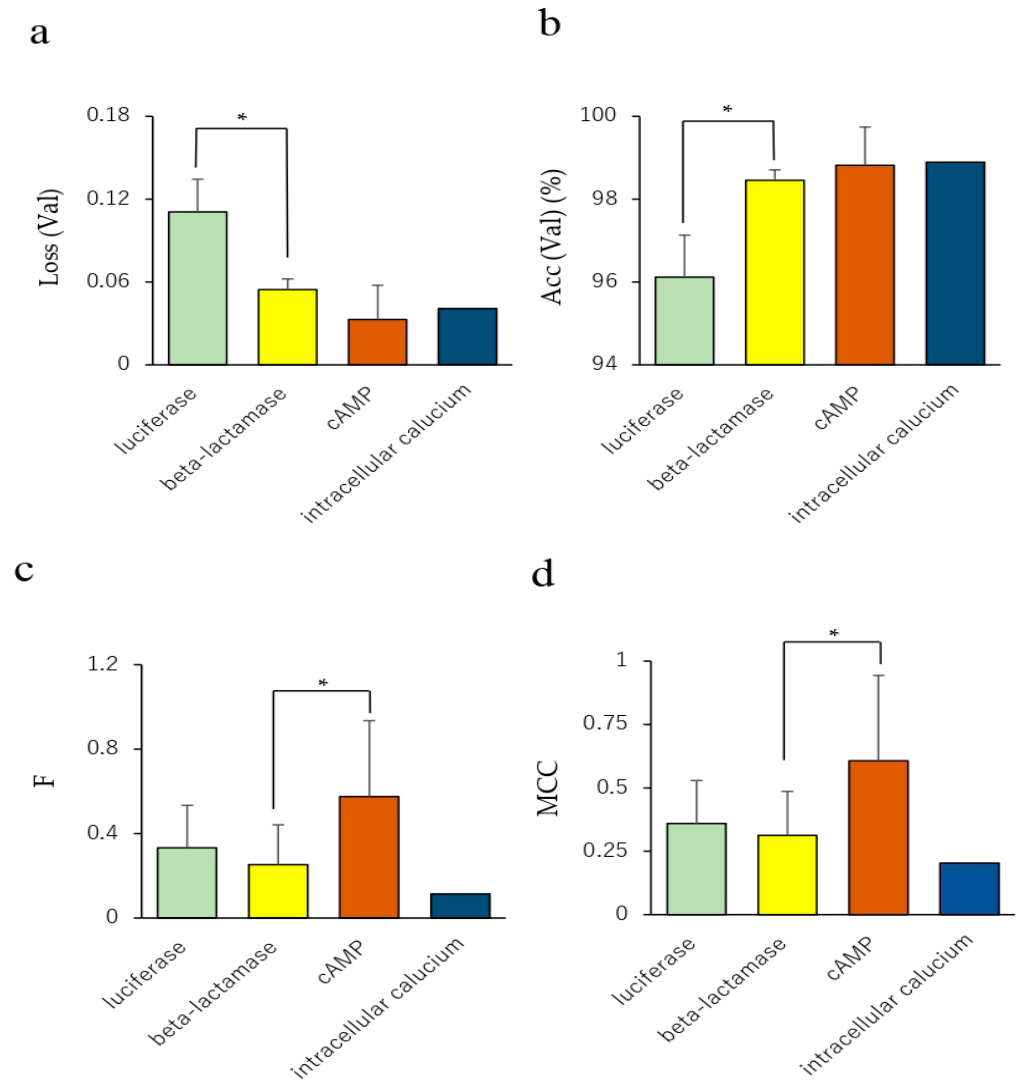
Figure 6. Comparison of prediction performance among four in vitro assays. ( a ) Loss in the Val dataset, ( b ) accuracy in the Val dataset, ( c ) accuracy in the Test dataset. n = 14, 17, 3, and 1 for luciferase, beta-lactamase, cAMP, and intracellular calcium assays, respectively. Each bar indicates the average of the performance metric of the four in vitro assays with standard error. * p < 0.05 by Tukey–Kramer’s honestly significant difference test.